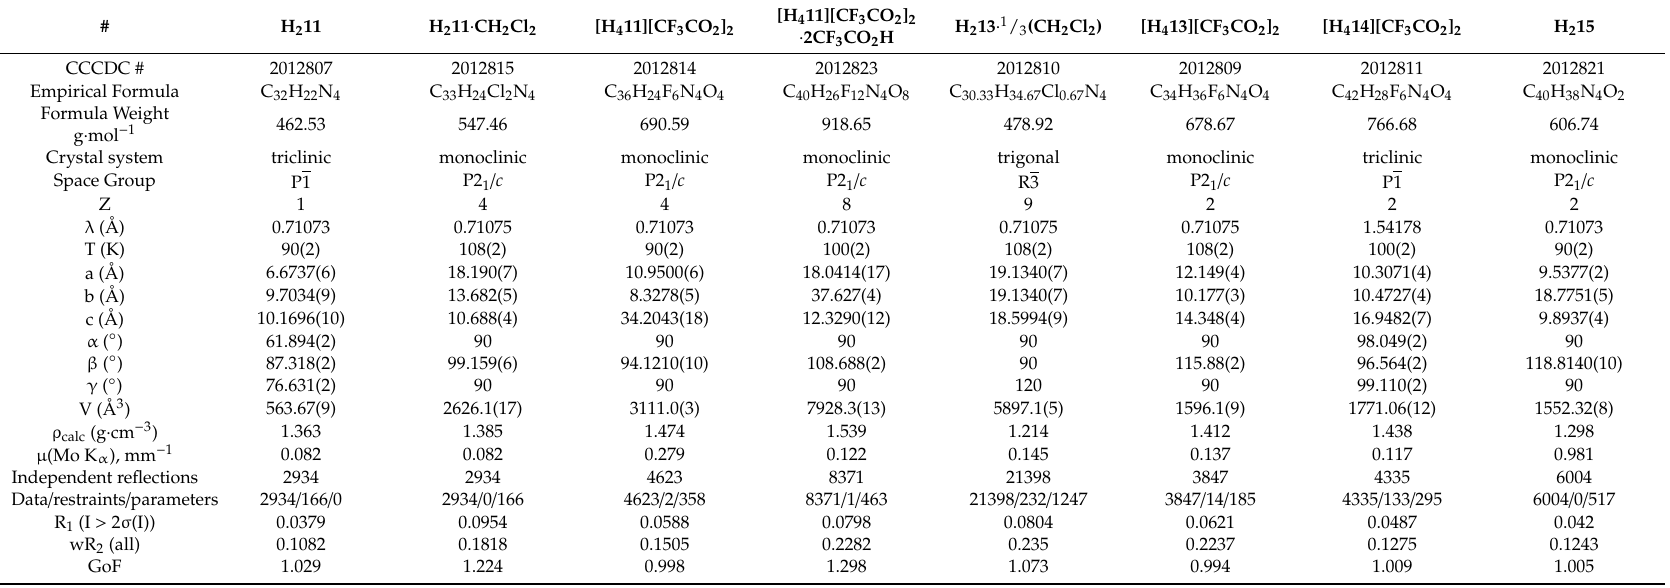
Table 1. Crystallographic tables for compounds